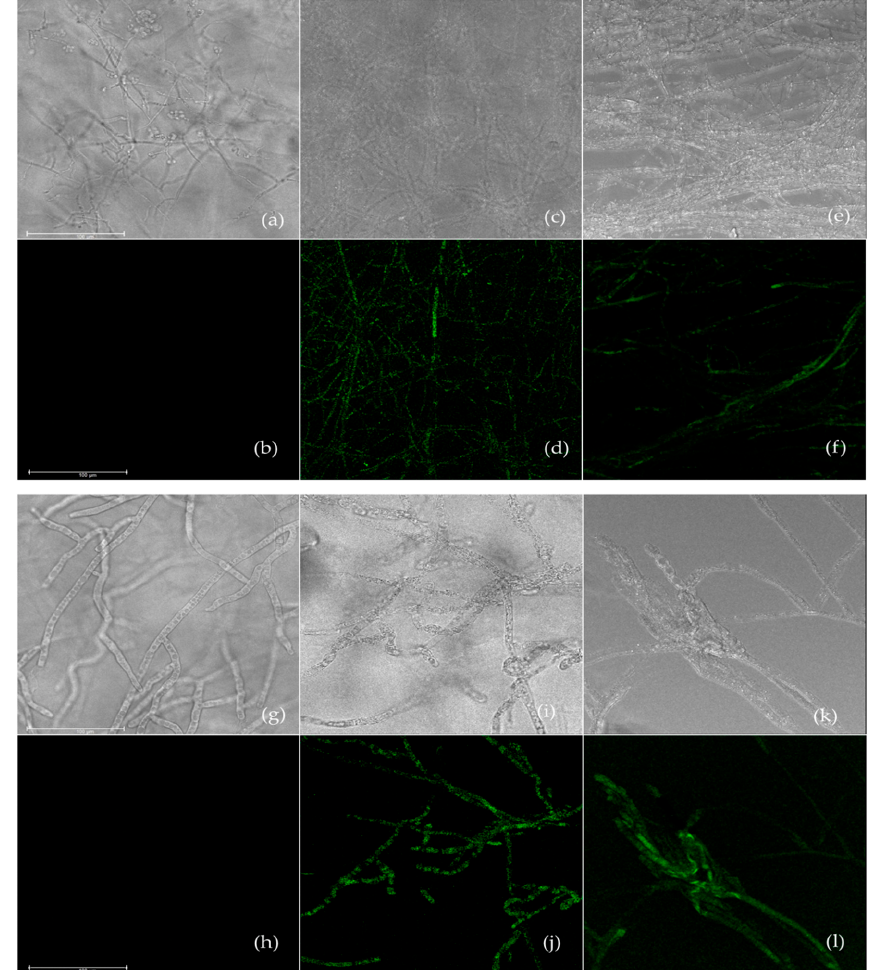
Figure 2. Confocal laser scanning microscopy images of ROS generation. Bright mode ( a ) and confocal image ( b ) of untreated R. quercus-mongolicae . Bright mode ( c ) and confocal image ( d ) of R. quercus-mongolicae treated with thymol. Bright mode (e) and confocal image (f) of R. quercus-mongolicae treated with carvacrol. Bright mode ( g ) and confocal image (h) of untreated R. solani . Bright mode ( i ) and confocal image ( j ) of R. solani treated thymol. Bright mode (k) and confocal image ( l ) of R. solani treated with carvacrol. Scale bar = 50 µ